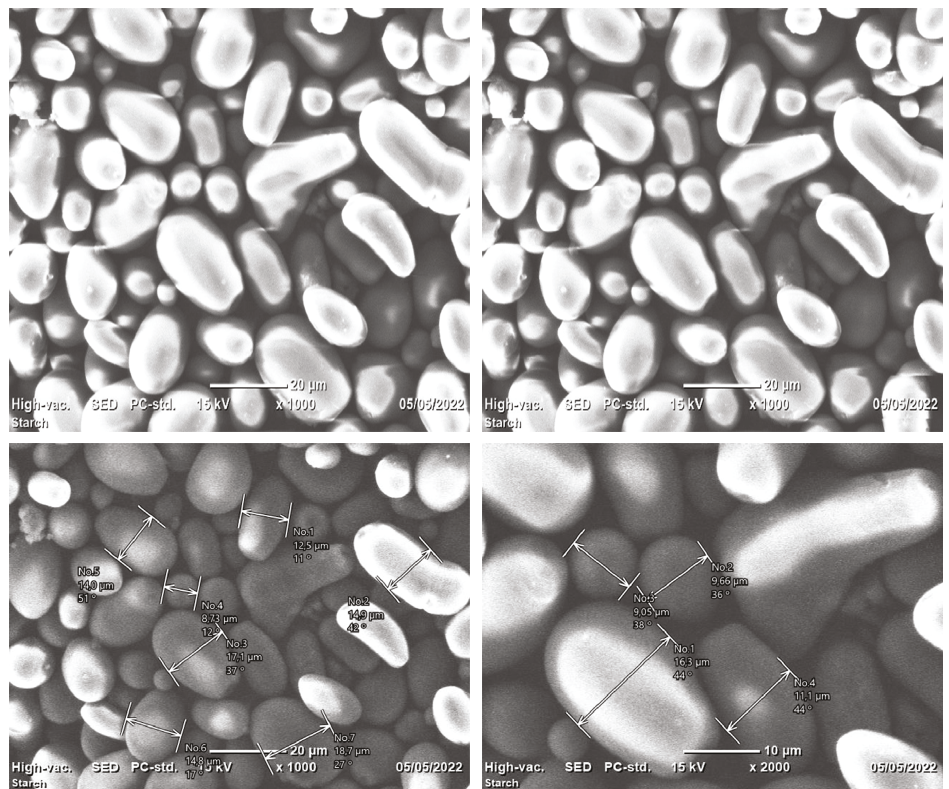
Figure 5: Morphological structure of avocado starch ( × 1000, × 2000 magnifications).